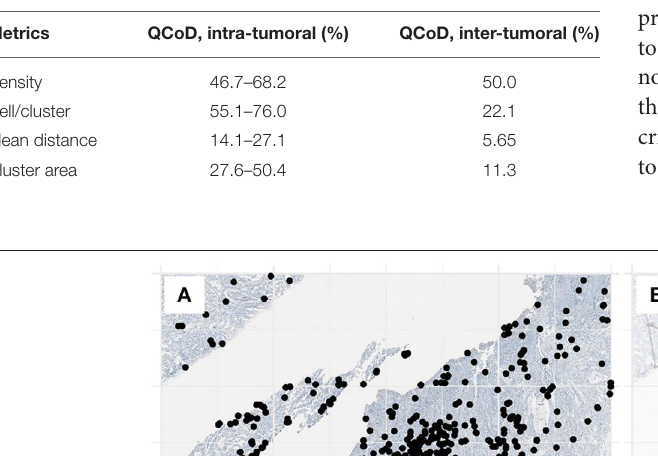
Frontiers in Oncology |